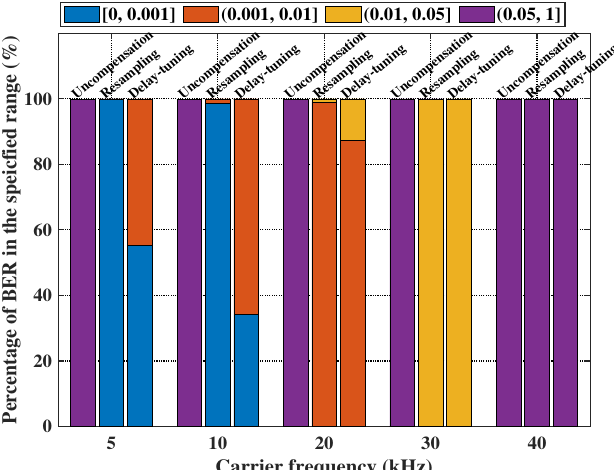
Figure 9. The BER outputs of different communication schemes under different carrier frequency conditions at Doppler = − 8